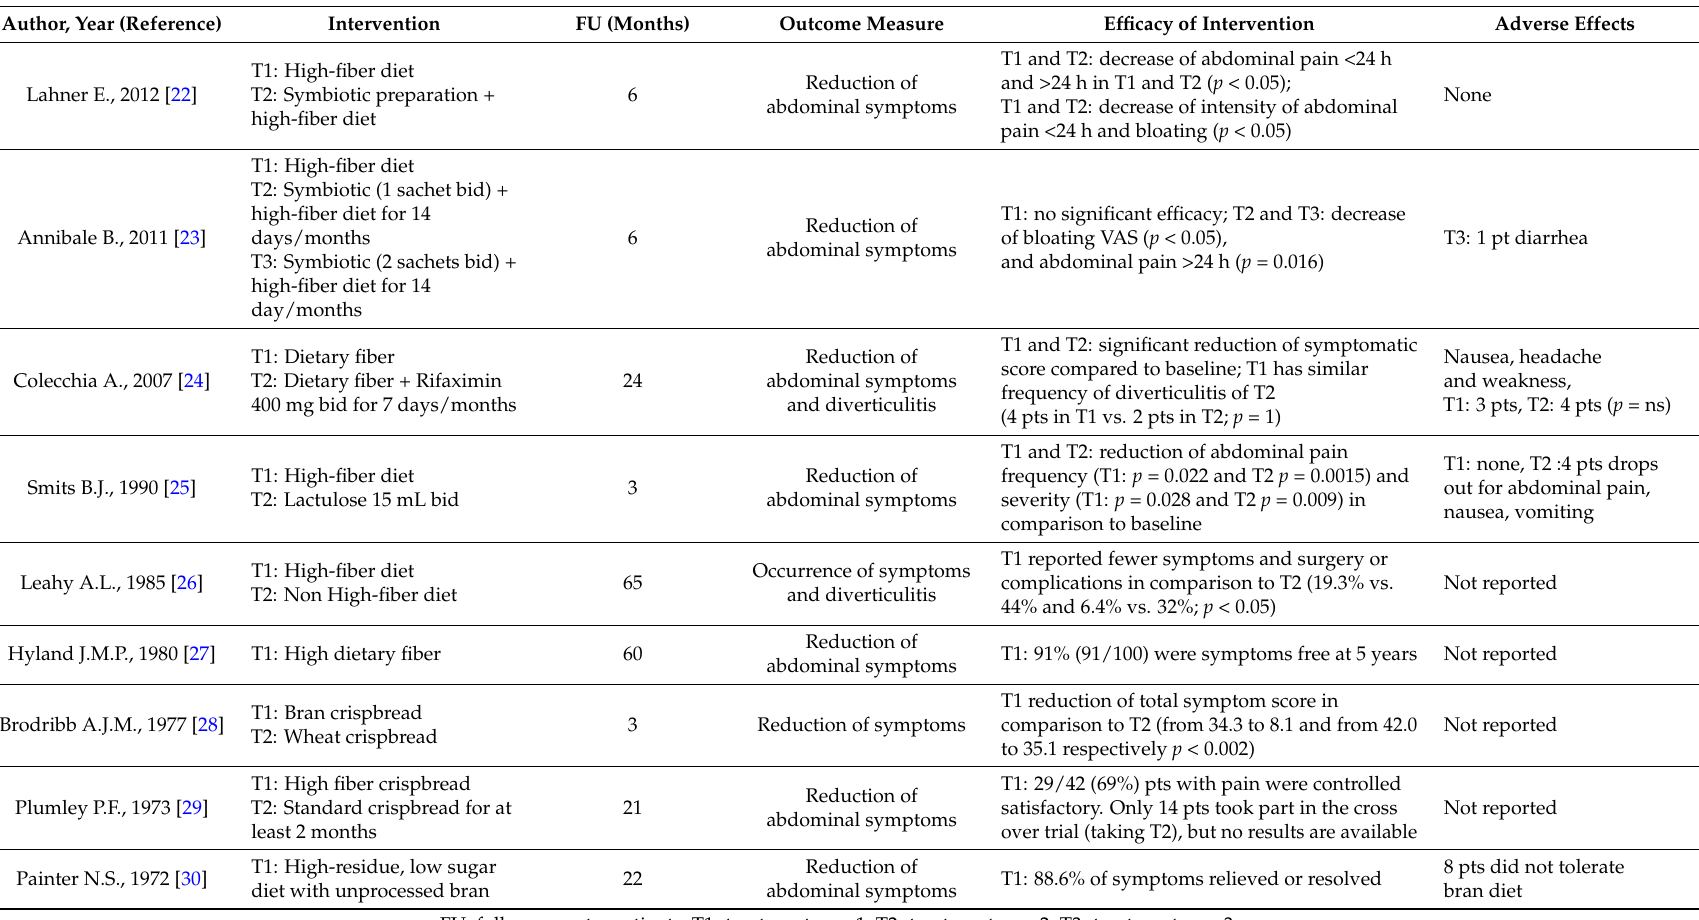
Table 3. Intervention and follow-up protocol in the selected studies of dietary fiber treatment in symptomatic uncomplicated diverticular disease